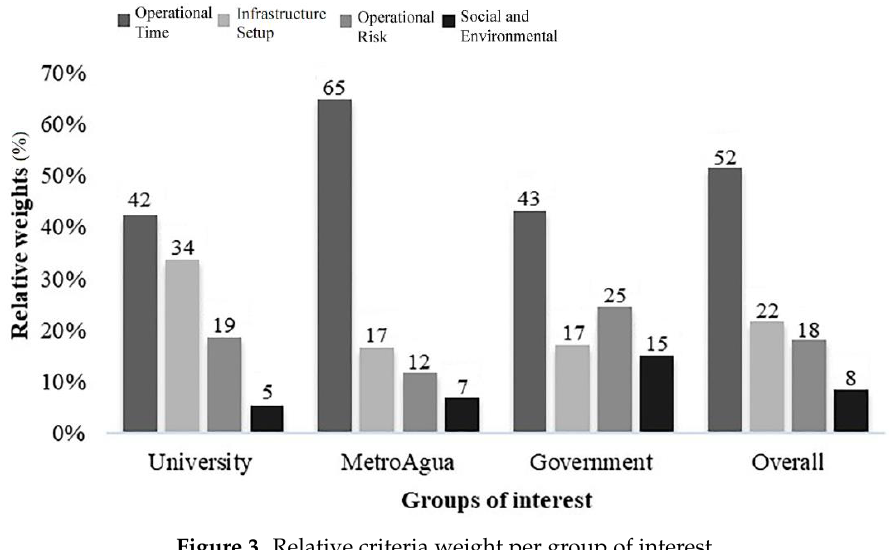
Figure 3. Relative criteria weight per group of interest.